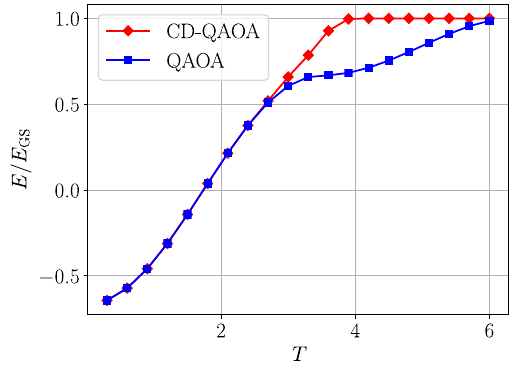
FIG. 16. Single spin- 1 = 2 state preparation: energy density against protocol duration for CD-QAOA with A f Z; X; Y g (red) and conventional QAOA with A QAOA ¼ f Z; X g (blue). The value of q is 3 for both methods. For conventional QAOA, we train two possible alternating patterns [i.e., ð Z → X → Z Þ and ð X → Z → X Þ ] and pick the best one for comparison. The model parameters are the same as in Fig. 1 with J ¼ 0